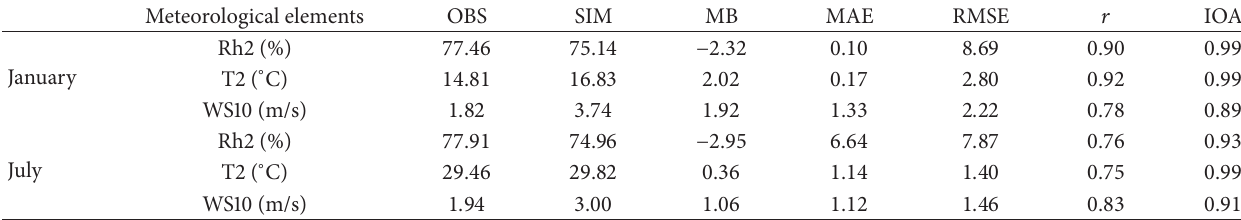
Table 1: Comparison of simulated value and observed value of 2 m relative humidity, 2 m temperature, and 10m wind speed. Meteorological